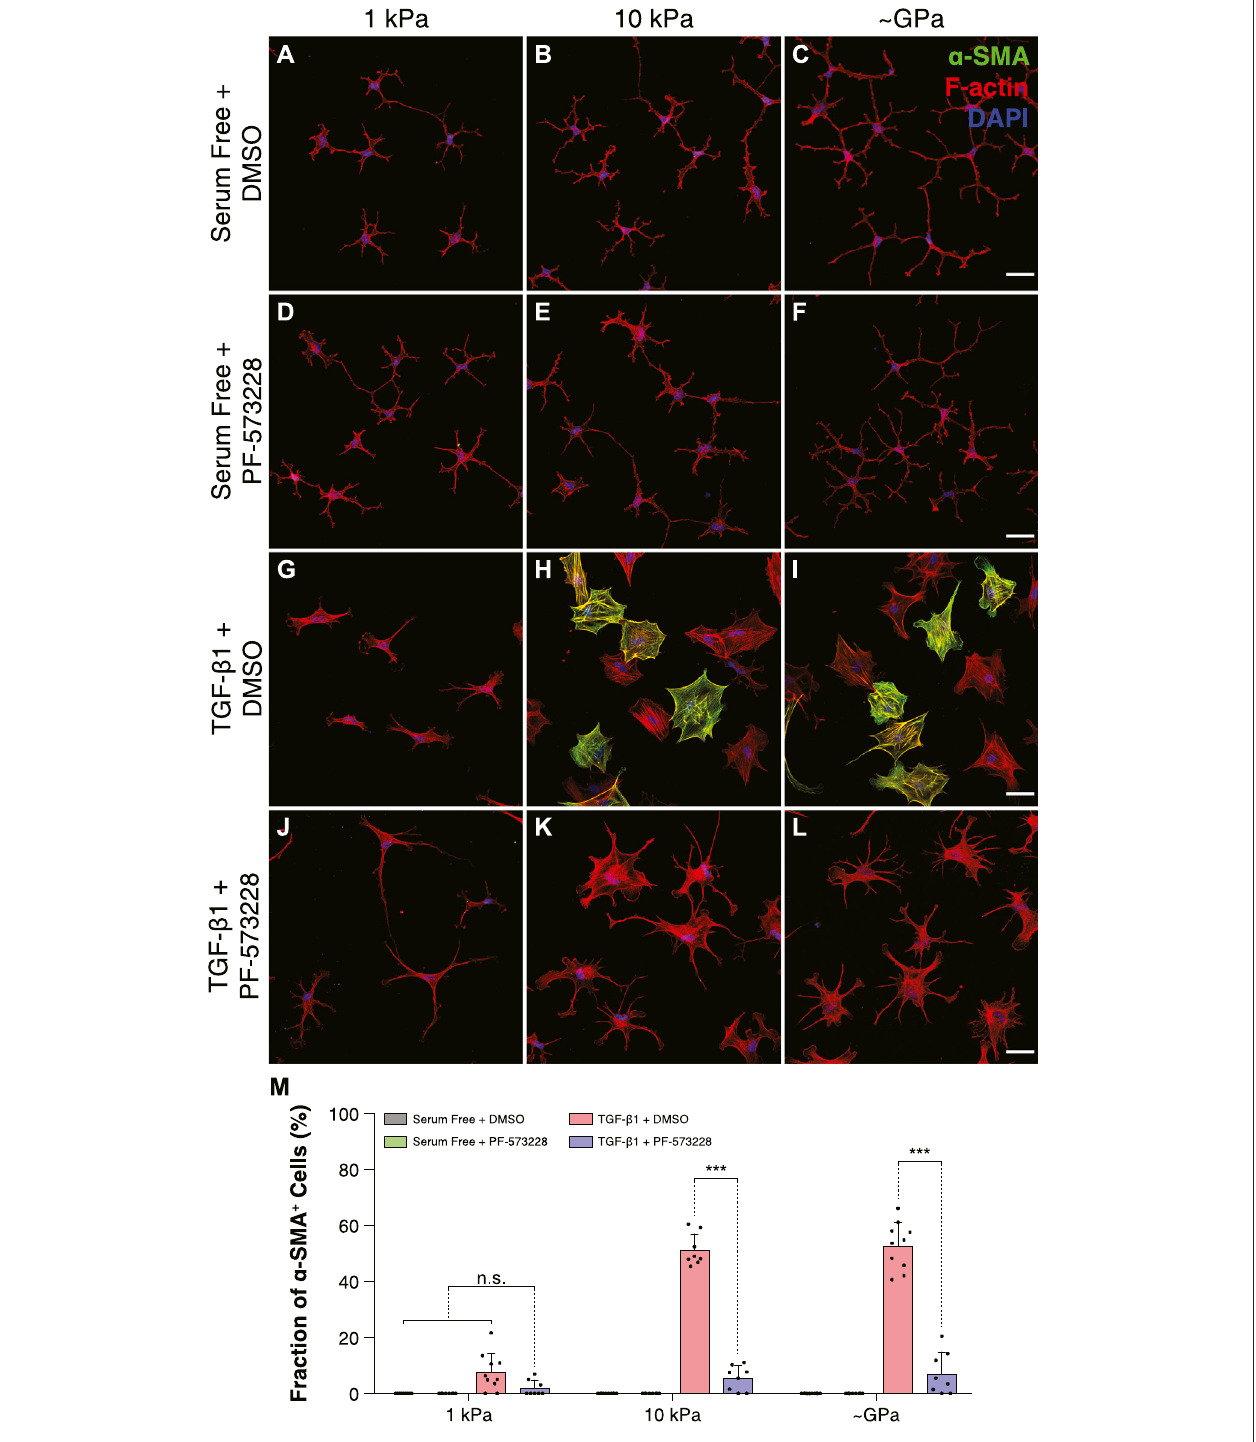
FIGURE 3 | FAK inhibition disrupts stiffness-dependent differences in myo fi broblast differentiation in response to TGF- β 1. (A – L) Characteristic confocal fl uorescence images of cells cultured on either functionalized 1 kPa (A,D,G,J) or 10 kPa (B,E,H,K) PA substrata, or collagen-coated glass (C,F,I,L) coverslips. Cells were cultured for 5 days in either serum-free conditions (A – F) or in medium containing exogenous TGF- β 1 (G – L) , and in either the presence (D – F,J – L) or absence (A – C,G – I) ofthe FAK inhibitor, PF-573228. Cells were stained for α -SMA immuno fl uorescence (green), aswell asF-actin (red) and DAPI (blue).Scale bars, 50 μ m. (M) Quanti fi cation ofthe fraction of α -SMA-positivecells. Error bars represent mean ±s.d. for n = 8 substrates from 4experimental replicates. A two-way ANOVA witha Tukey post-hoc test was used to evaluate signi fi cance among groups. (***, p < 0.001).